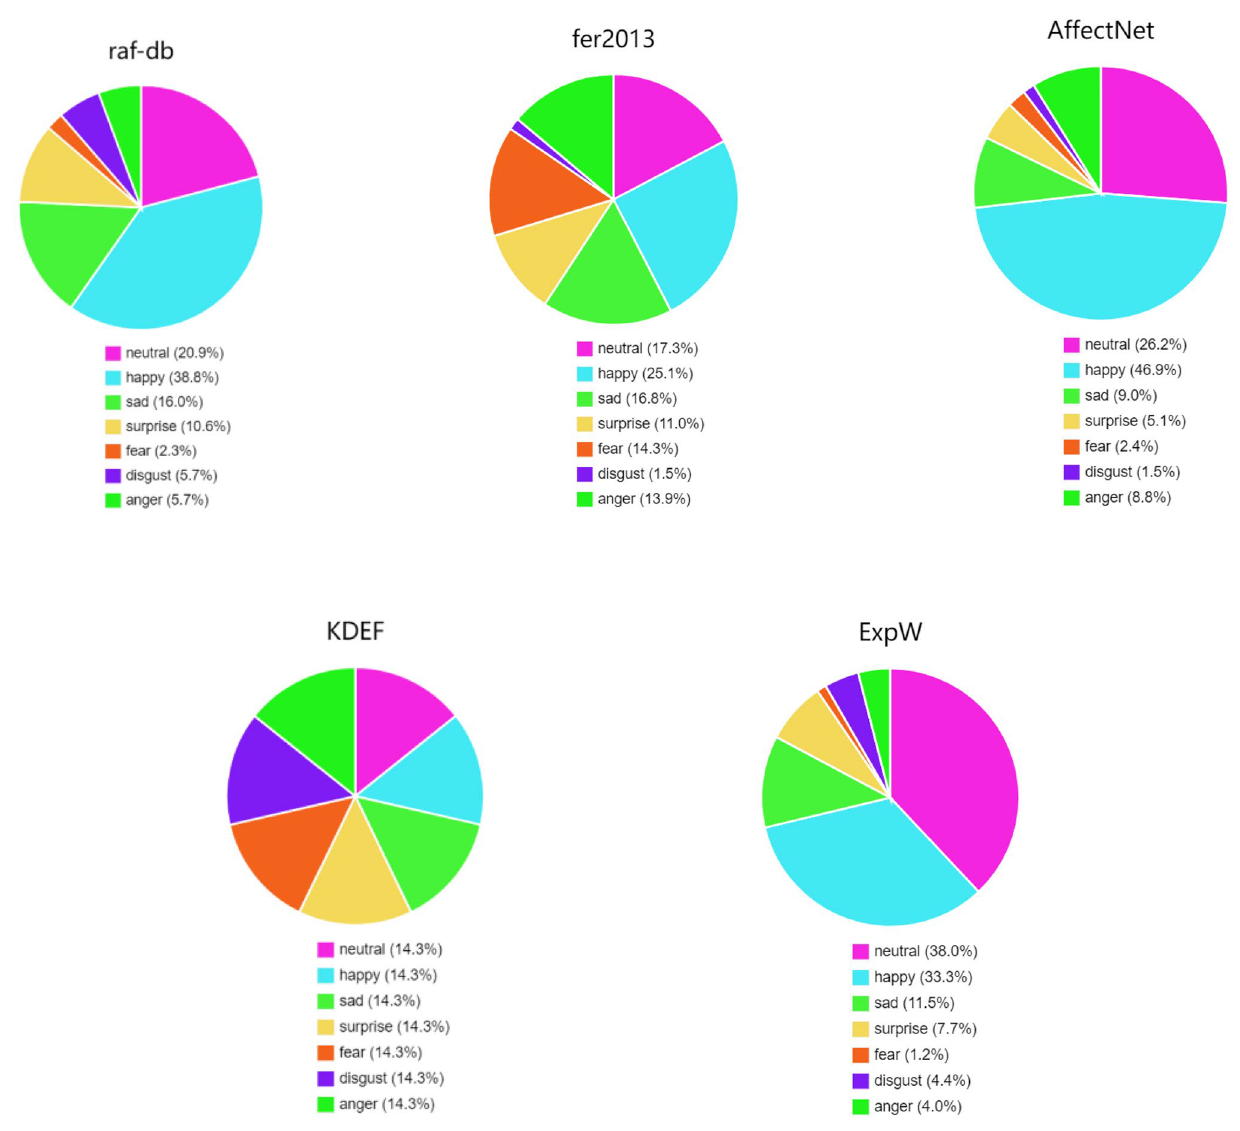
Fig. 2 Statistics of severe imbalance of dataset categories